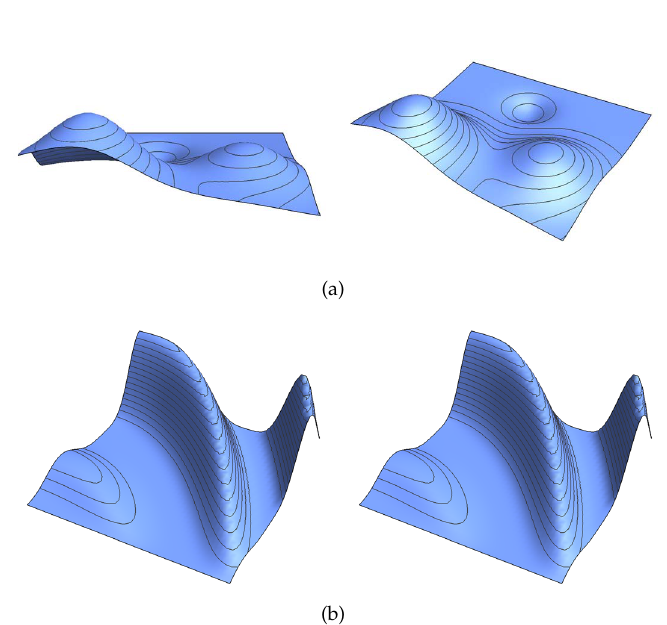
Figure 16. Quasi-interpolants for Franke’s function ( a ) and Nielson’s function ( b